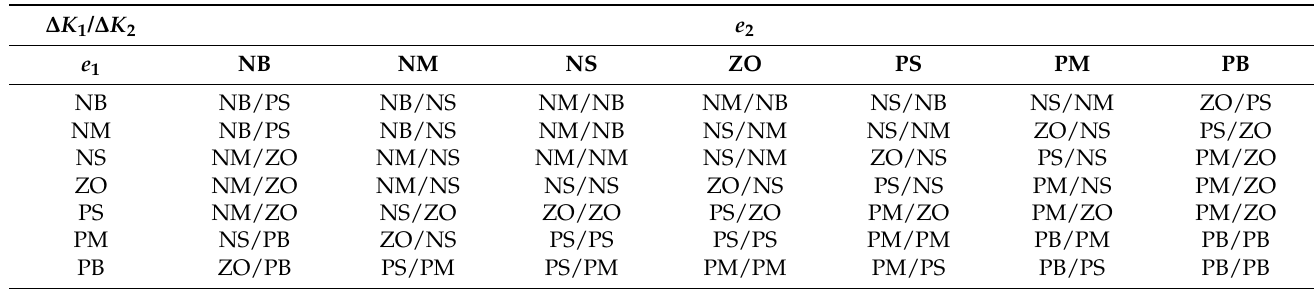
Table 4. Fuzzy rules for ∆ K 1 and ∆ K 2 with inputs e 1 and e 2